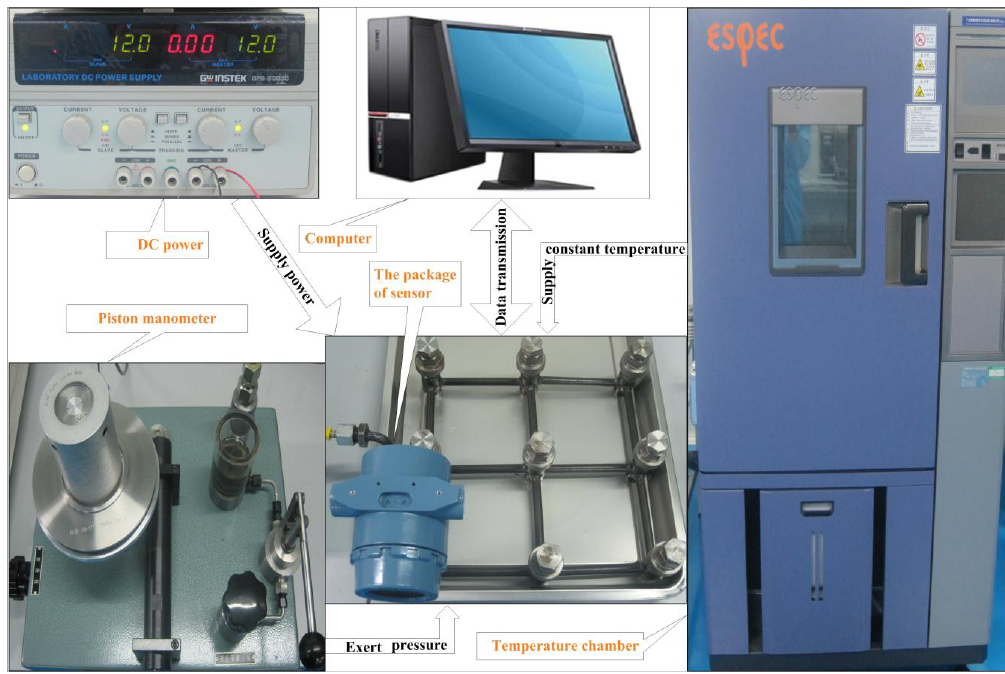
Figure 7. The experiment setting of the system.